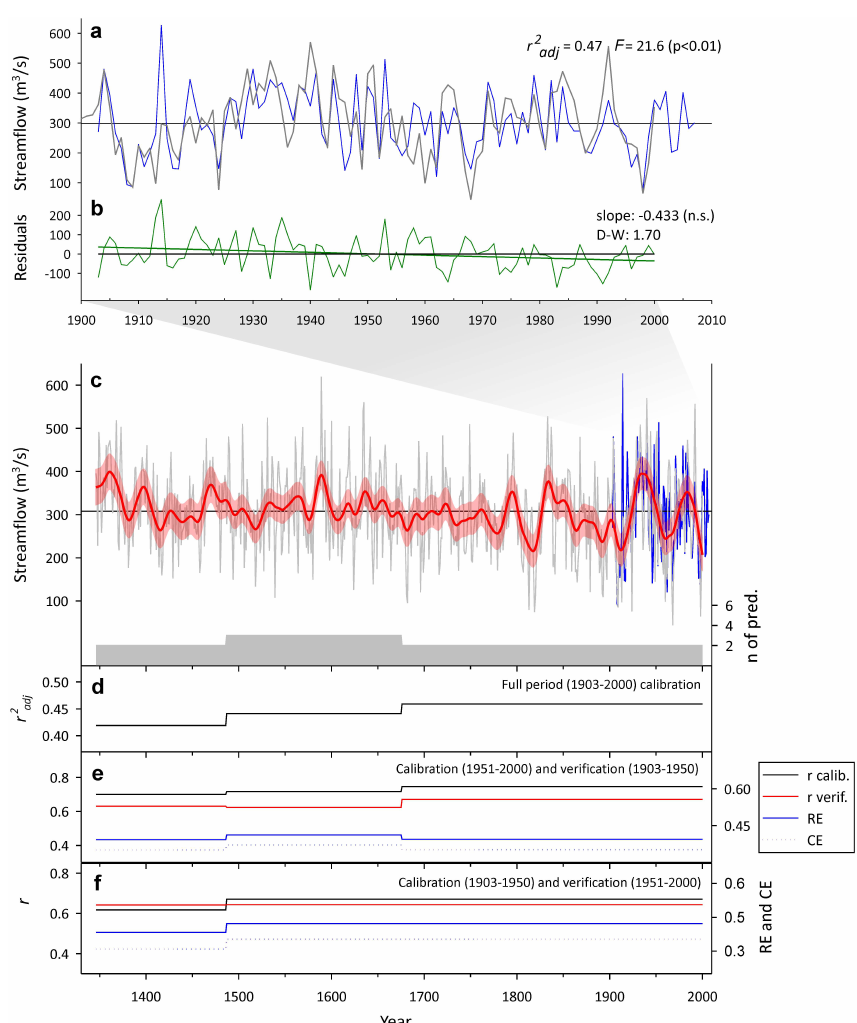
Fig. 3. October–June Neuqu´en River streamflow reconstruction for the past 655yr. (a) Instrumental (blue) and nested tree-ring reconstructed (gray) streamflow for the 1903–2000 common period. The coefficient of determination (an indicator of the proportion of variance explained by regression) adjusted for the degrees of freedom in the model ( r 2 ), the F -value of regression (the ratio between the explained and the un- adj explained variability in the model) for Model 2 are also shown. Regression residuals for the reconstruction are shown in (b) . The linear trend of regression residuals (slope) and the Durbin-Watson (D-W) statistics used to test for first-order autocorrelation of the regression residuals are also indicated. (c) Nested tree-ring based reconstruction of the October–June Neuqu´en River streamflow for the period 1346–2000. The thick red line represents a 25-yr cubic spline to emphasize the long-term variations in the Neuqu´en River streamflow reconstruction. Red shading represents the ± 2SE uncertainty bands in this smoothed series. Gray shading reflects the number of predictors available over time. ) for the full period calibration. (e) and (f) Pearson correlation coefficient ( r ), (d) Variations in the adjusted coefficient of determination ( r 2 adj the reduction of error (RE), the coefficient of efficiency (CE) for the split calibration and verification